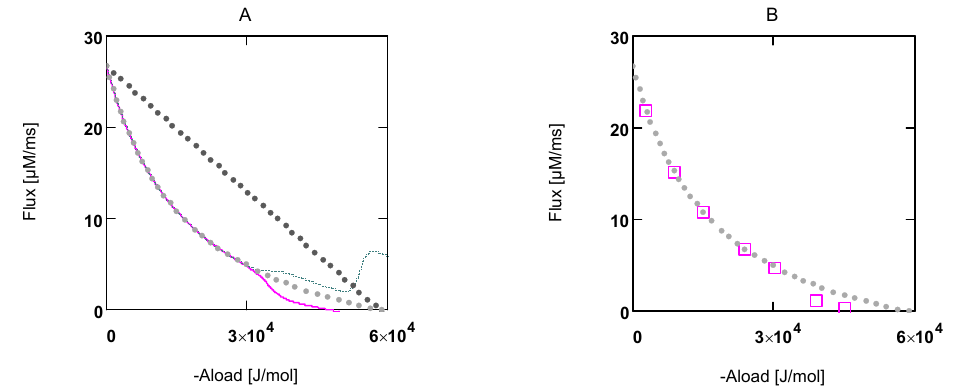
Figure 1. Flux as a function of load potential at 10.8 µM [Ca 2+ ]. A: (grey dots) according to equation 9b; (light grey dots) according to equation 9c or 9d; (red line) according to equation 11a; (green line) according to equation 11b. B: (light grey dots) according to equation 9c or 9d; (red squares) results from simulation SIM GLYgen